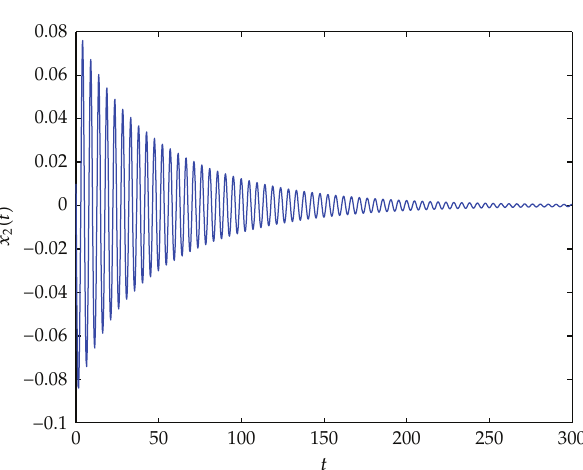
Figure 2: Trajectories graphs of the system (cid:2) 4.1 (cid:3) with τ 1 (cid:6) 0 . 003 ,τ 2 (cid:6) 0 . 004, and τ 1 (cid:7) τ 2 (cid:6) 0 . 007 < τ 0 ≈ 0 . 01. The equilibrium E ∗ (cid:2) 0 , 0 (cid:3) is asymptotically stable. The initial value is (cid:2) 0.05, 0.01 (cid:3) .